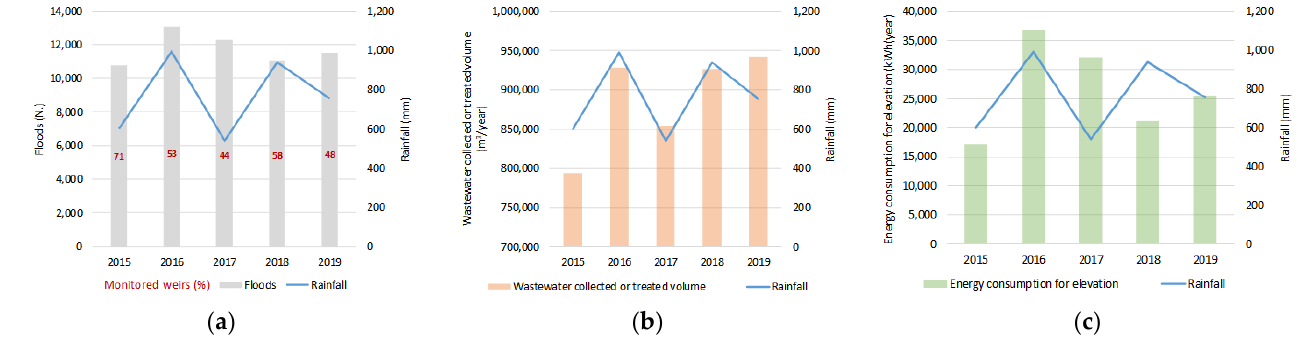
Figure 4. National characterization for the evaluation of the W-E-G nexus: ( a ) floods, monitored weirs vs. rainfall, ( b ) wastewater collected or treated volume vs. rainfall, and ( c ) energy consumption for pumping vs. rainfall.